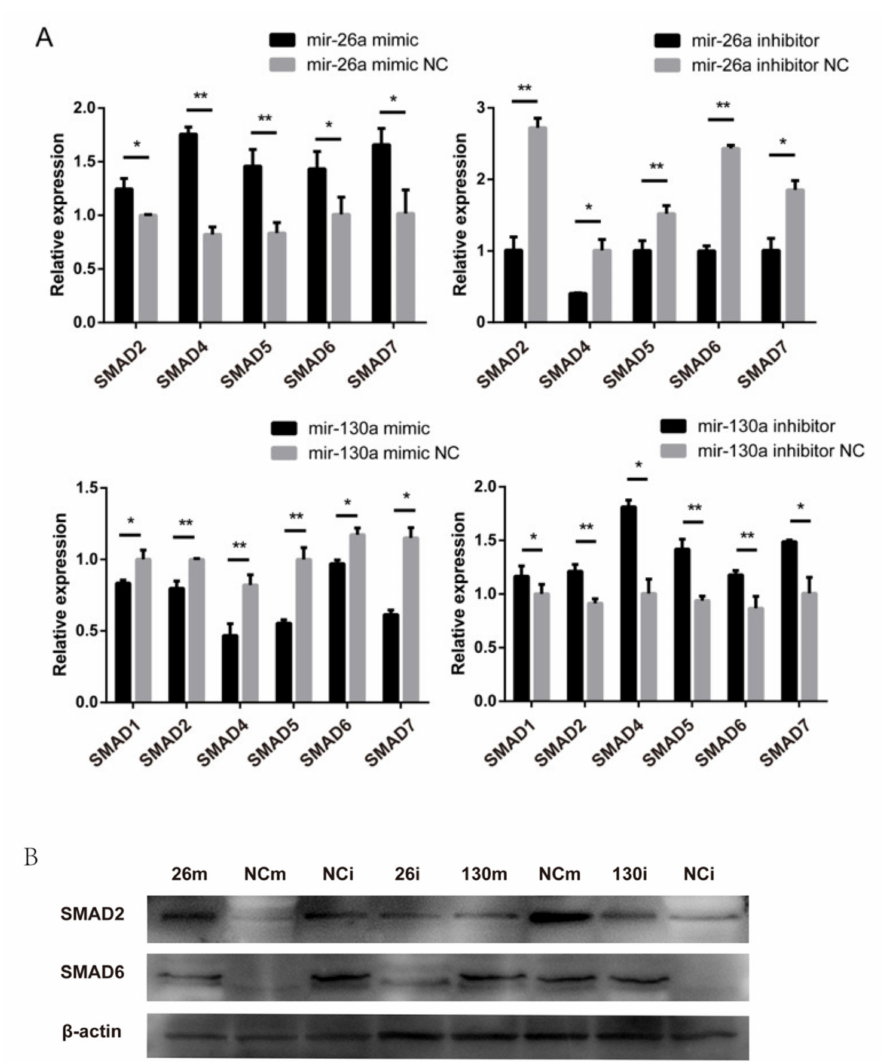
Figure 9. The expression of related genes in the TGF- β / SMAD pathway after the overexpression or inhibition of miR-26a or miR-130a. ( A ) The SMAD family expression after a transfection with a miR-26a and miR-130a mimic, negative control (NC), and miR-26a and miR-130a inhibitor, determined by RT-qPCR 48 h after transfection ( n = 3). The marker * represents a significant di ff erence between the experimental group and the control group ( p < 0.05), while ** represents an extremely significant di ff erence between the experimental group and the control group ( p < 0.01). ( B ) Western blot analysis of SMAD2 and SMAD6 after a transfection with the miR-26a and miR-130a mimic, negative control (NC), and miR-26a and miR-130a